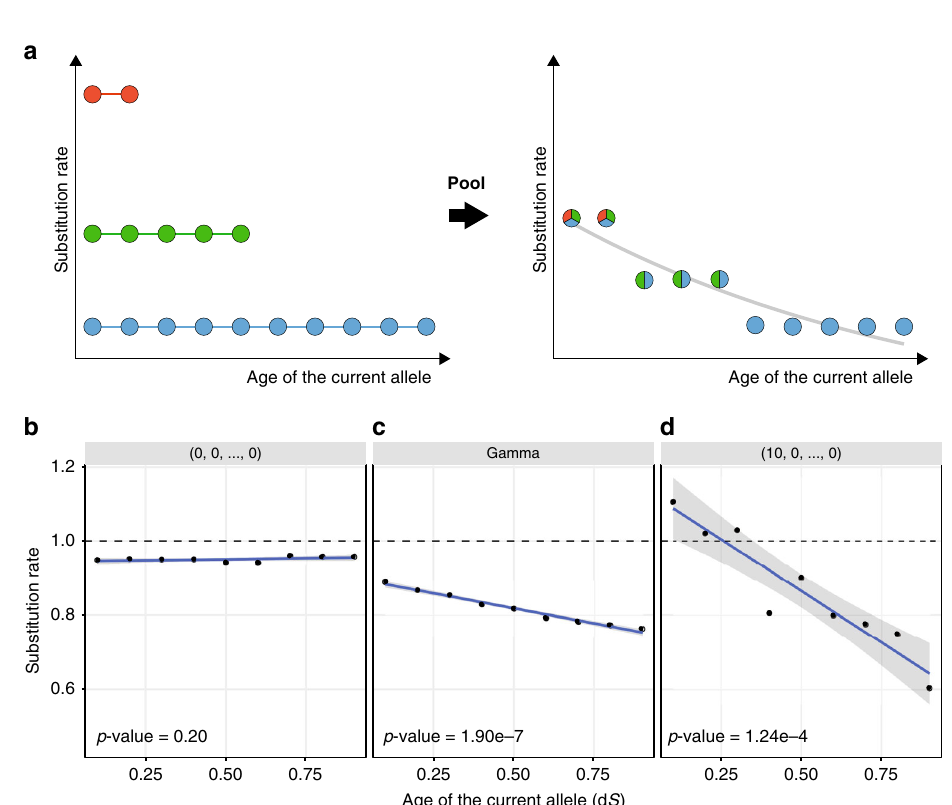
Fig. 4 Heterogeneity of substitution rates among alleles on static SPFLs imitates entrenchment. a Consider three classes of alleles, characterized by different constant substitution rates: fast (red), moderate (green), and slow (blue) alleles. For each allele, we can calculate the substitution frequency on the phylogenetic branches located at different evolutionary distances from the gain of that allele (each dot corresponds to a single branch). If the dynamics of replacement of these alleles are analyzed separately for each substitution-rate class, no spurious signal of entrenchment or senescence is observed (left). However, if alleles from different classes are pooled together, the substitution frequency appears to decrease with time, mimicking the signal of entrenchment (right). On a static fl at SPFL ( b , log fi tness vector = [0, 0, ..., 0]), i.e., when the substitution rates for all 20 alleles are the same, the frequency of replacement of the current allele on some branch of the phylogenetic tree does not depend on the time since the allele gain (each dot corresponds to a single branch). However, on a gamma-distributed SPFL ( c ), the heterogeneity of fi tness of the alleles produces entrenchment-like decline of replacement rate of the current allele with time, although the SPFL remains static. The effect is even more pronounced on a more rugged SPFL ( d , log fi tness vector = [10, 0, ..., 0]). The p values are obtained with linear